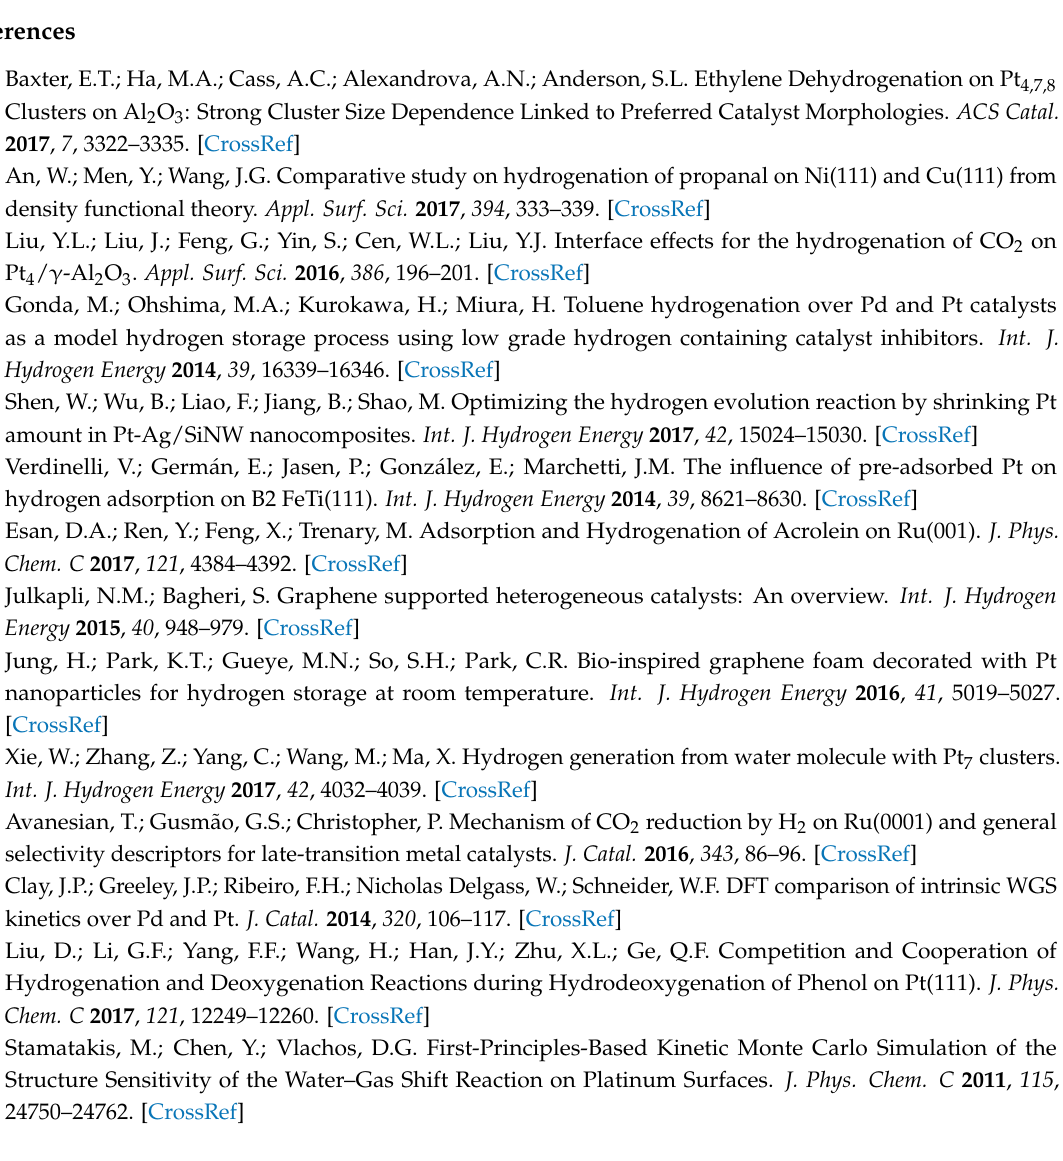
Table S1: Frequencies of H(a) on Pt(111) and H 2 . Table S2: Frequencies of 2H-fcc, transition state and H 2 . Table S3: Frequencies of H-fcc, transition state and H-hcp. Table S4: The pre-exponential factors of H 2 desorption and H(a) diffusion. Table S5: E ads (eV) of the typical configurations of H(a) and H 2 ; E a of H(a) diffusion and H 2 desorption on Pt(111) by DFT and DFT-D methods. Figure S1: Effects of the diffusion rate constant on the H 2 TDS spectra by kMC